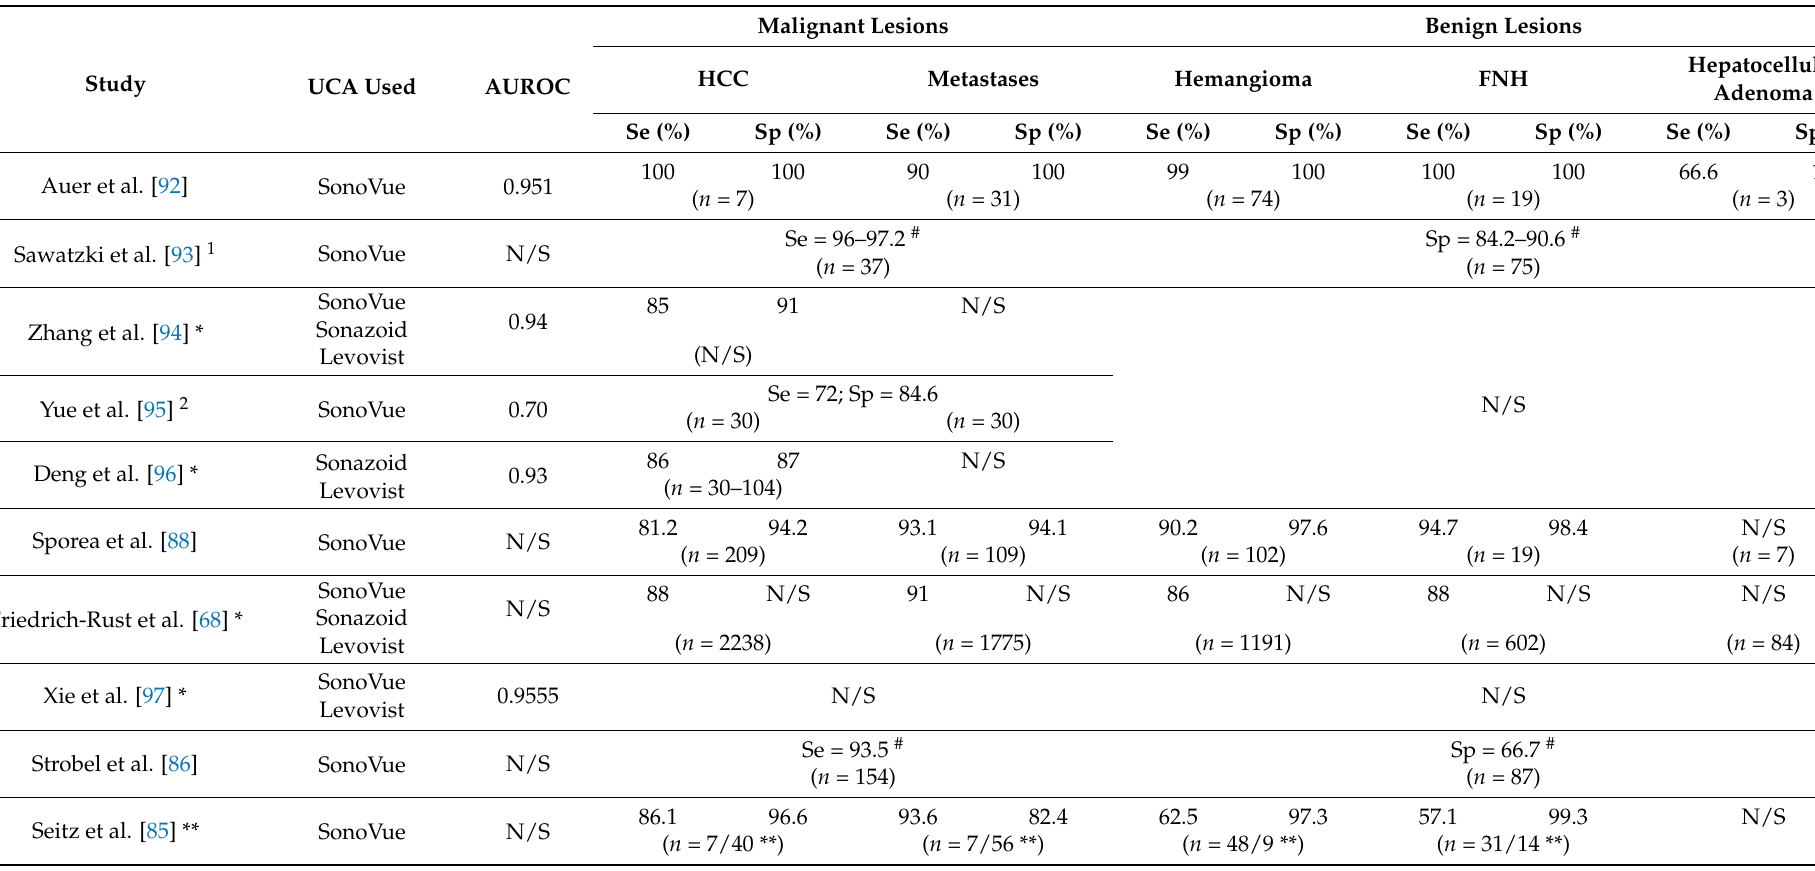
Table 4. CEUS capacity using different contrast agents (SonoVue, Sonazoid, Levovist) for differentiating between malignant versus benign